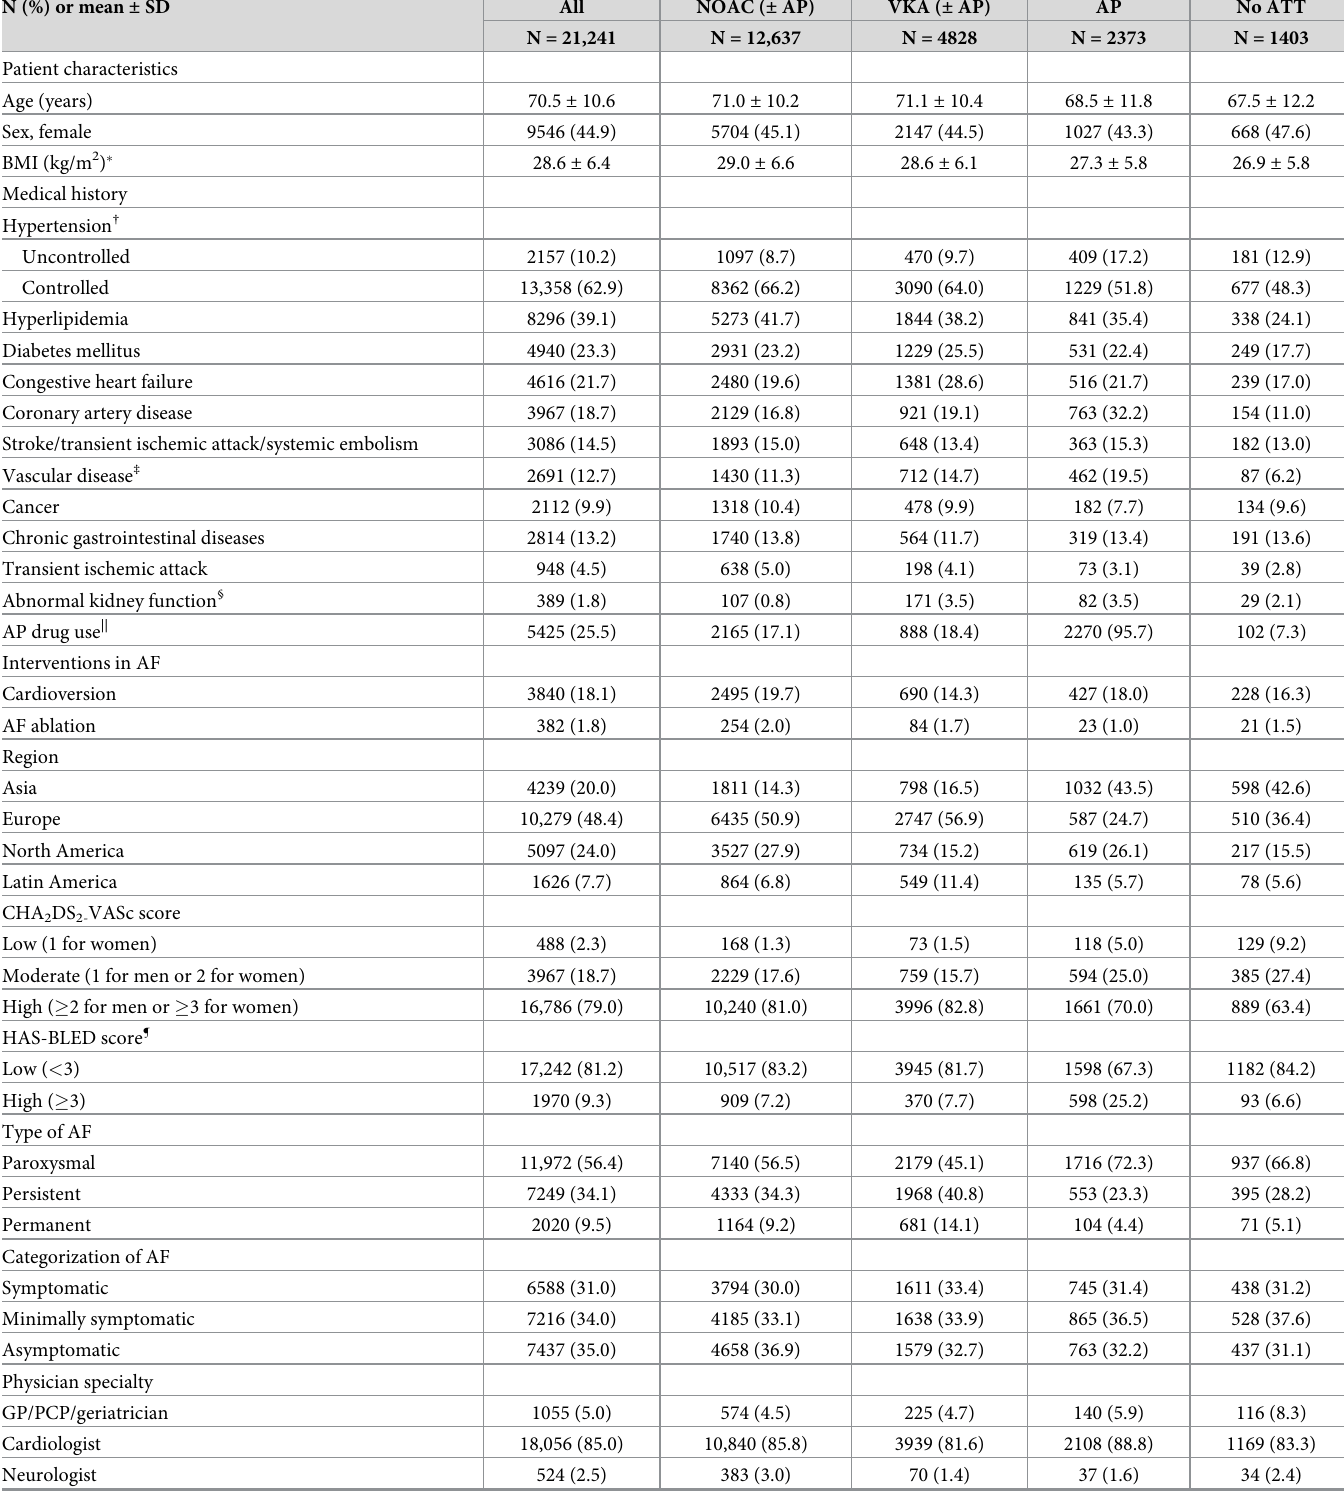
Table 1. Baseline characteristics by ATT for phase III patients enrolled between 2014 and